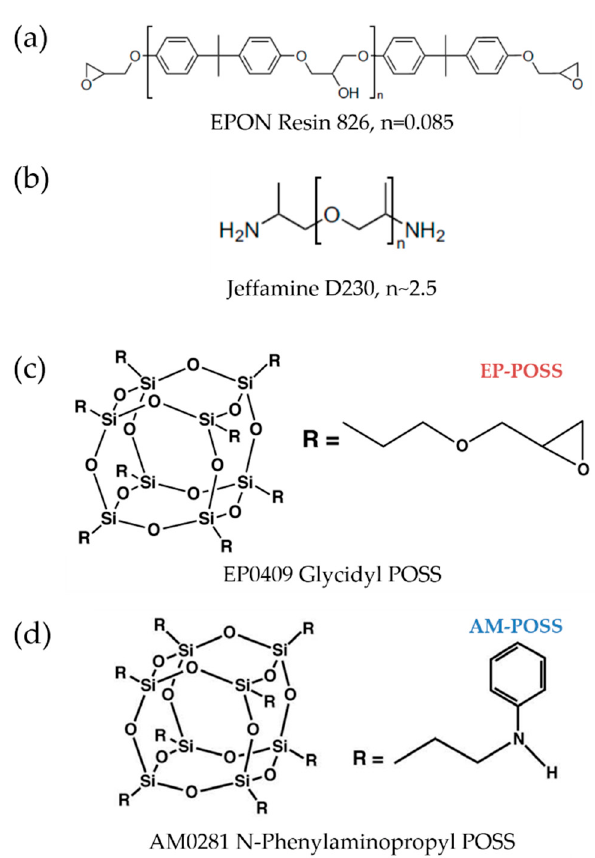
Figure 11. Molecular structures of ( a ) EPON 826 epoxy resin monomer, ( b ) Jeffamine D230 crosslinker, ( c ) EP0409 glycidyl POSS (EP–POSS), and ( d ) AM0281 N -phenylaminopropyl POSS (AM–POSS) [51,77,78]. Reprinted from Polymer, Vol. 50, Xie and Rousseau, Facile tailoring of thermal transition temperatures of epoxy shape memory polymers, 1852–1856, Copyright (2009), with permission from Elsevier.